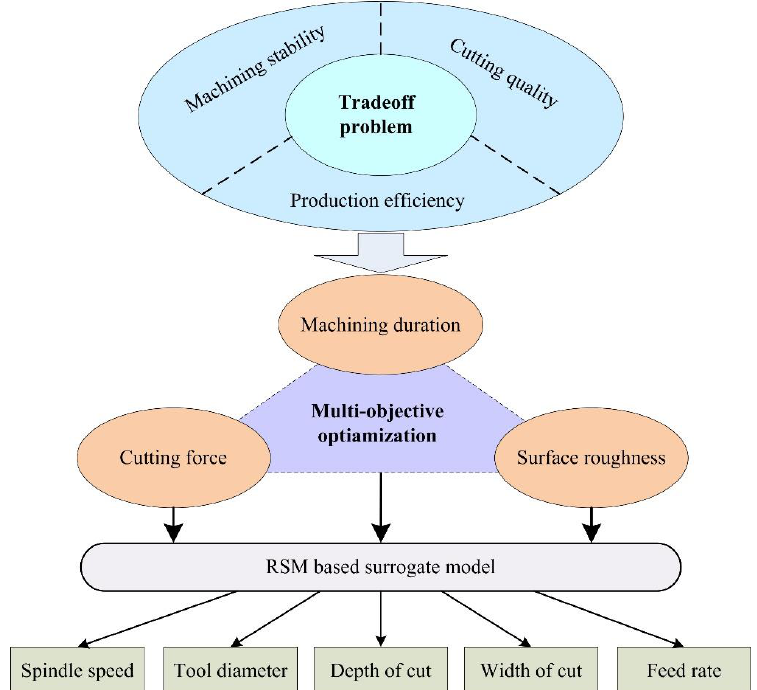
Figure 1. Framework of the equilibrium decision-making approach.